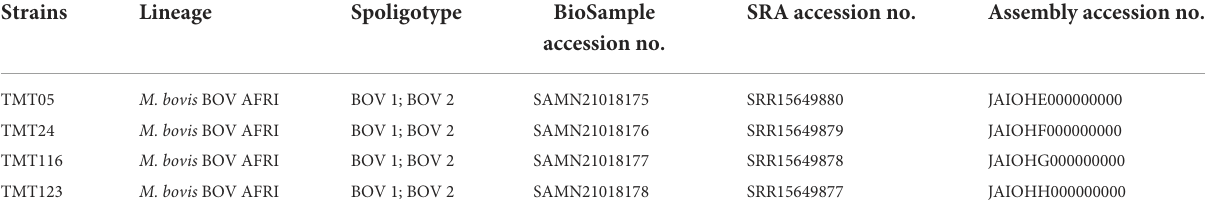
TABLE 5 Data on strains deposited at the